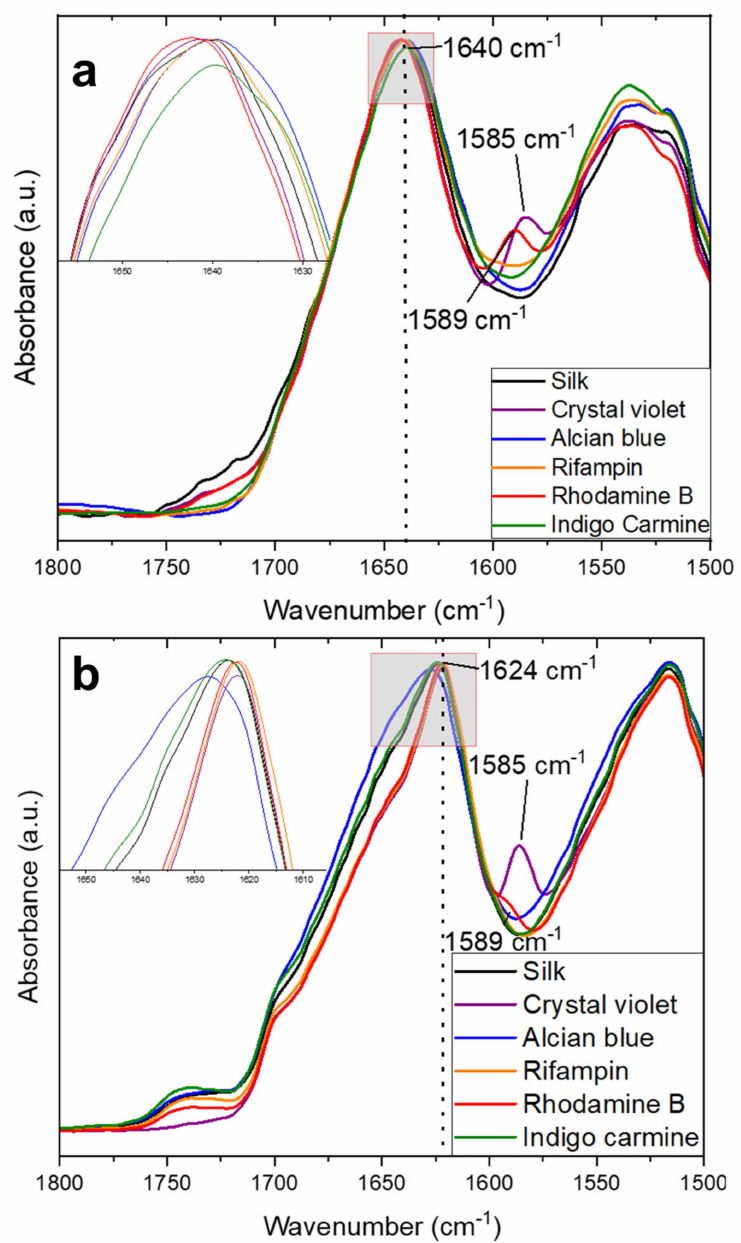
Figure 1. FTIR spectra of the Amide I and II regions of air-spun silk fibers ( a ) before and ( b ) after release of model